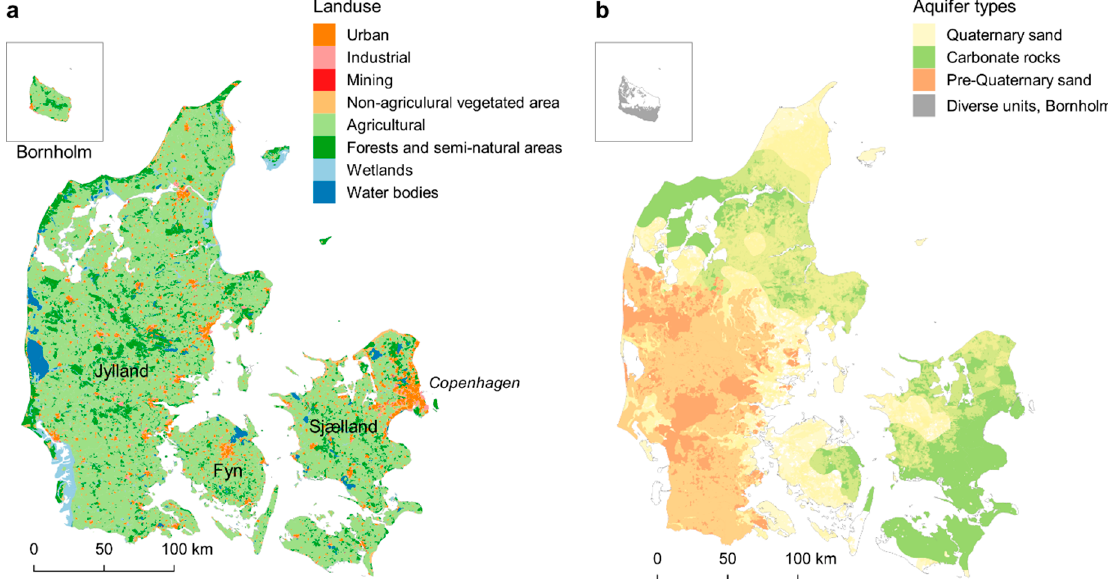
Figure 1. ( a ) Land-use map (CORINE 2012, downloaded from https://download.kortforsyningen.dk/content/corine-land- cover (accessed on 20 May 2020)). ( b ) Groundwater bodies included in this study; the Quaternary sand is shown with transparency above the other aquifer types, so the underlying carbonate and pre-Quaternary sand aquifers can also be seen.